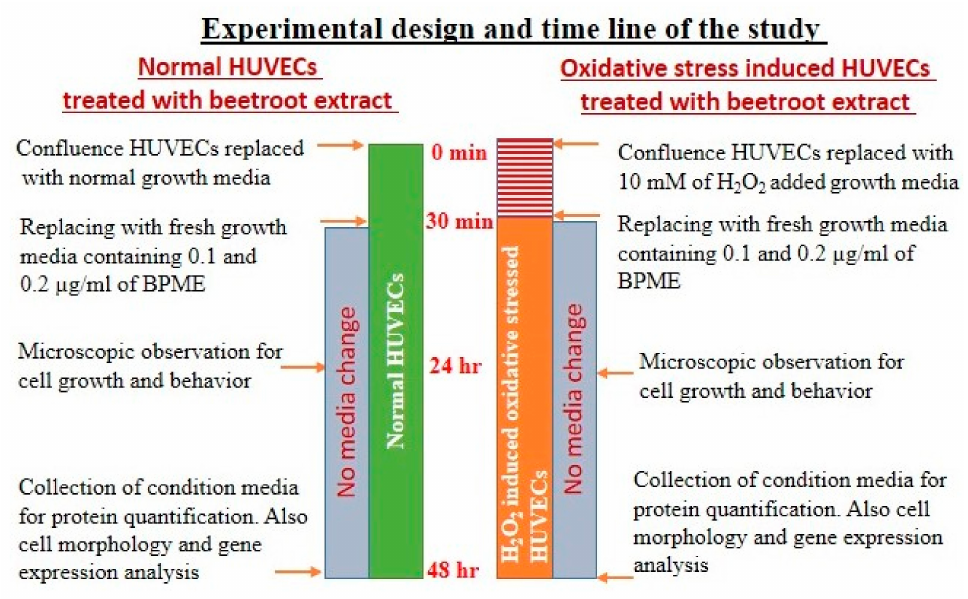
Figure 1. Diagrammatic representation of experimental design and timeline for the present